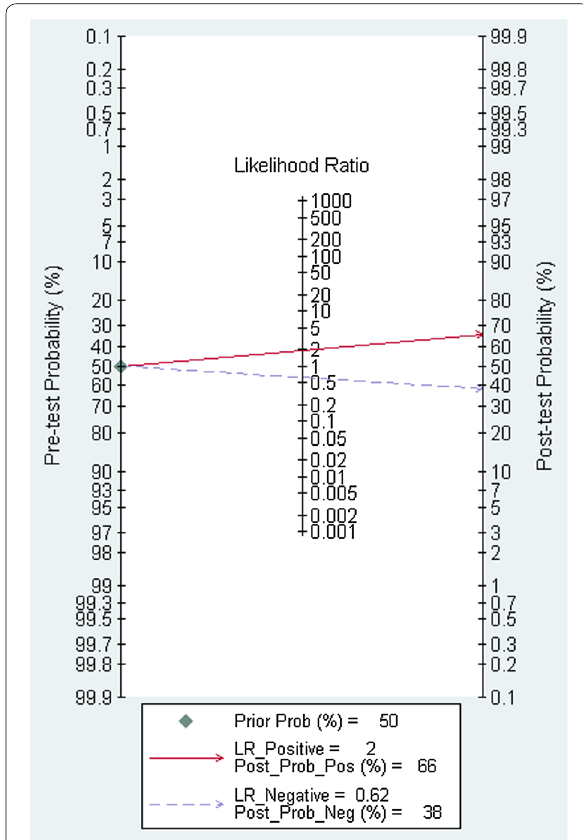
Fig. 8 Fagan’s nomogram plot to evaluate the clinical utility of APT in comparison to SPT for the diagnosis of patients with atopy dermatitis. The vertical axis on the left displays a fixed pre-test probability of 50%. Using the likelihood ratio in the middle axis, post-test prob- ability (patient’s probability of having the disease after the index test result was known) was obtained